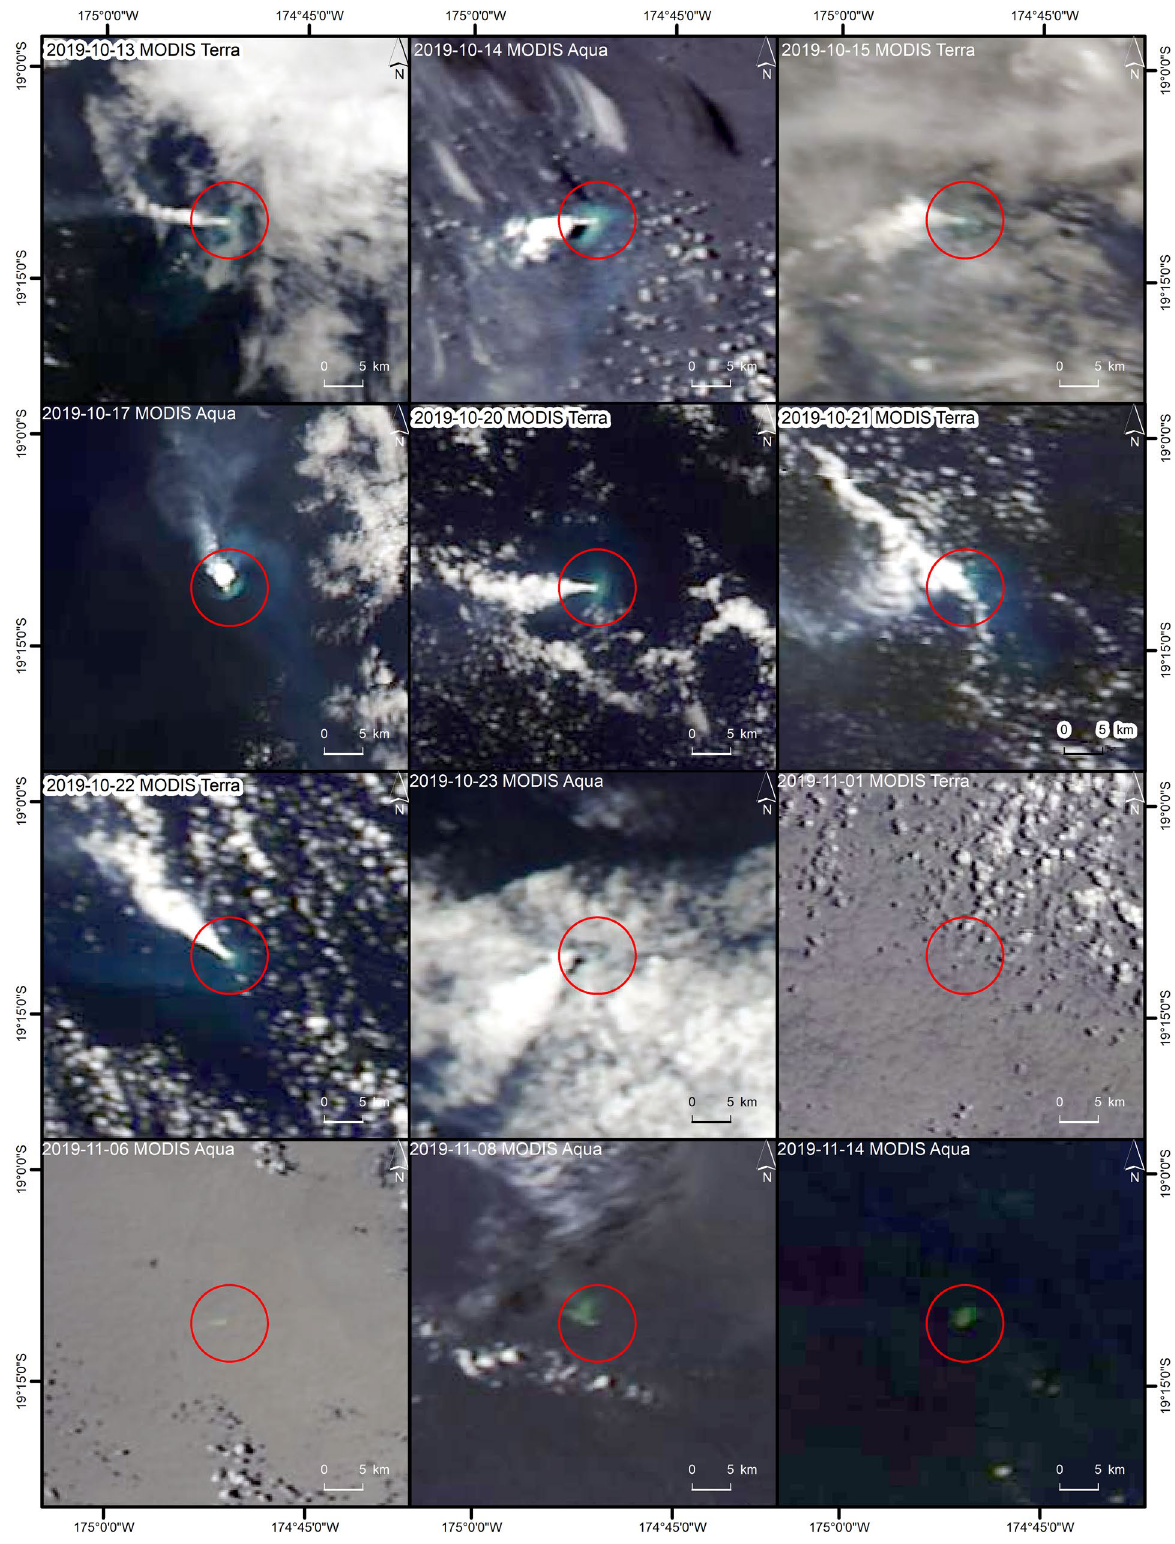
Figure 4. Volcanic water vapor plumes over Late’iki Volcano (red circle) as observed by MODIS Aqua and Terra from 13 to 23 October 2019. The imagery from 1 to 14 November 2019 show the temporal evolution of New Late’iki Island as observed by the MODIS sensor. MODIS RGB imagery with band combination 1/4/3. Background: NASA Worldview